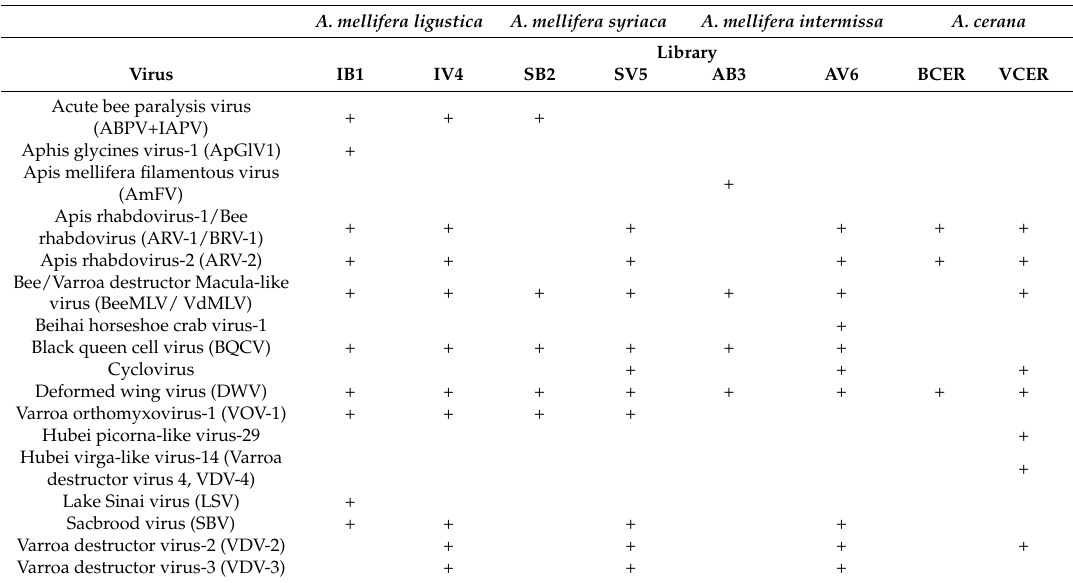
Table 3. Presence of viruses in honeybees and V. destructor mites by